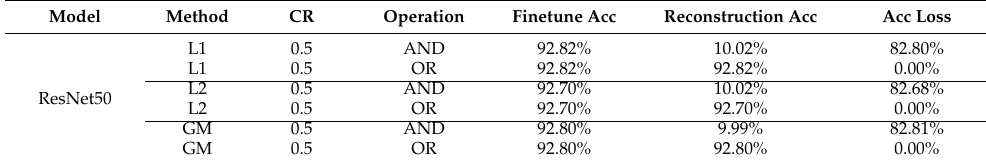
Table 7. Comparison between union and intersection operations applied to reconstruction. In the “Operation” column, “AND” means reconstructing residual blocks with the intersection operation, while “OR” means reconstructing residual blocks with the union operation. The “Finetune Acc” column denotes the accuracy after retraining the pruned model, “Reconstruction Acc” denotes the accuracy after reconstruction of the fine-tuned model, and “Acc Loss” indicates the accuracy drop between “Finetune Acc” and “Reconstruction Acc”, with smaller values being